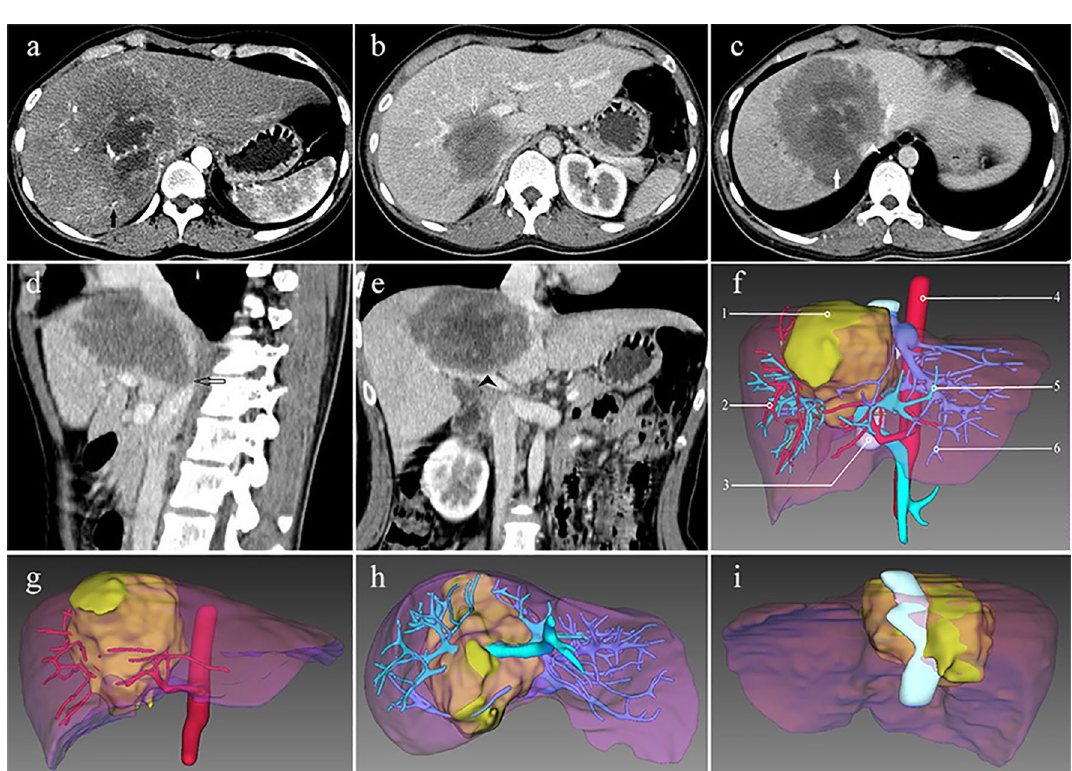
Figure 1. CT of a large hepatic alveolar echinococcosis located in the right liver lobe, caudate lobe and left medial lobe in case 21. Axial CT of the arterial phase ( a ) demonstrates that the right hepatic artery is of mild invasion by the lesion. Axial CT of the portal venous phase ( b ) displays the invasion of right portal vein with severe involvement (hollow arrow). Axial CT of the delayed phase ( c ) reveals obliteration of the right hepatic veins (arrow), and invasion of the second porta hepatis (arrowhead). Sagittal reconstruction of the portal venous phase data ( d ) displays severe invasion of retrohepatic vena cava (hollow arrow). Coronal reconstruction of the portal venous phase data ( e ) indicates the invasion of the first porta hepatis (arrowhead). Three-dimensional reconstruction image derived from the portal venous phase data ( f ) shows the location of the lesion and the relationship between the lesion and hepatic artery, portal vein, hepatic vein and inferior vena cava. The three- dimensional reconstruction images from arterial phase ( g ) and from the portal venous phase ( h and i ) data reflect the relationship between the lesion and hepatic artery, portal vein, hepatic vein and inferior vena cava in multiple-angle views, respectively. Notes 1, lesion; 2, hepatic artery; 3, inferior vena cava; 4, abdominal aorta; 5, portal vein; and 6, hepatic